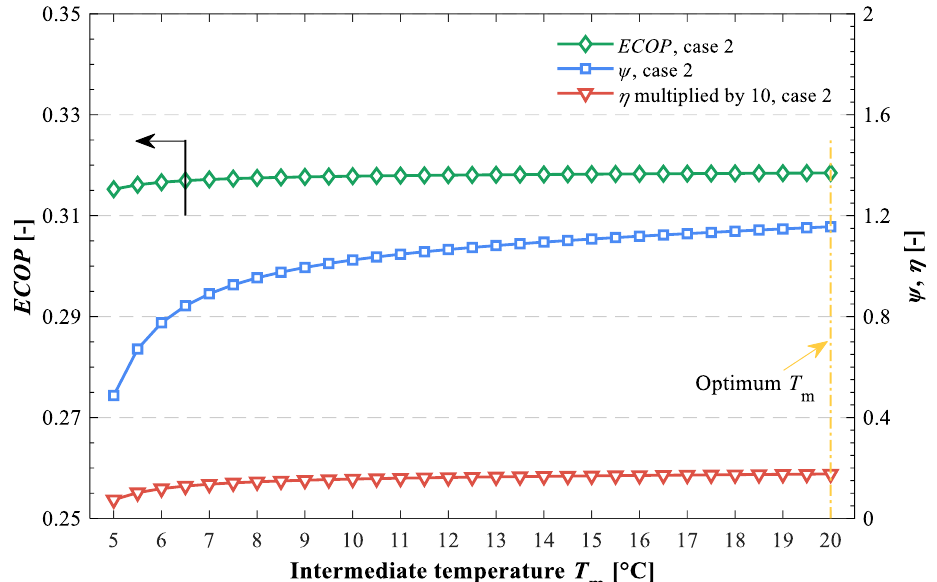
Figure 12. Effect of intermediate temperature on performance indicators for the layout with a cascade subcooling process in case 2.